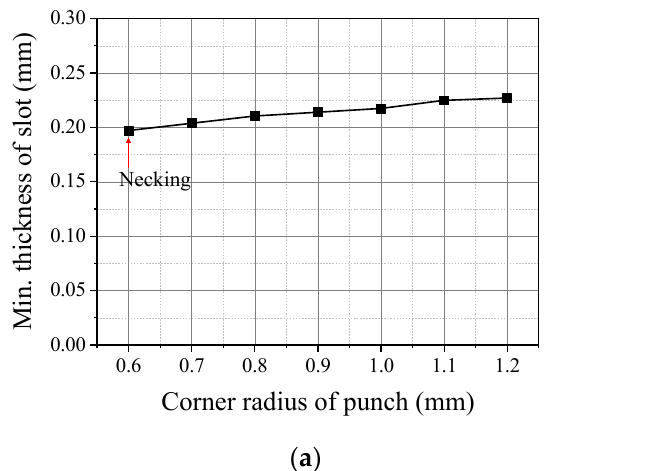
Figure 14. Variations of ( a ) minimum thickness and ( b ) contact length of the slot in the final forming stage process with respect to the corner radius of the punch.